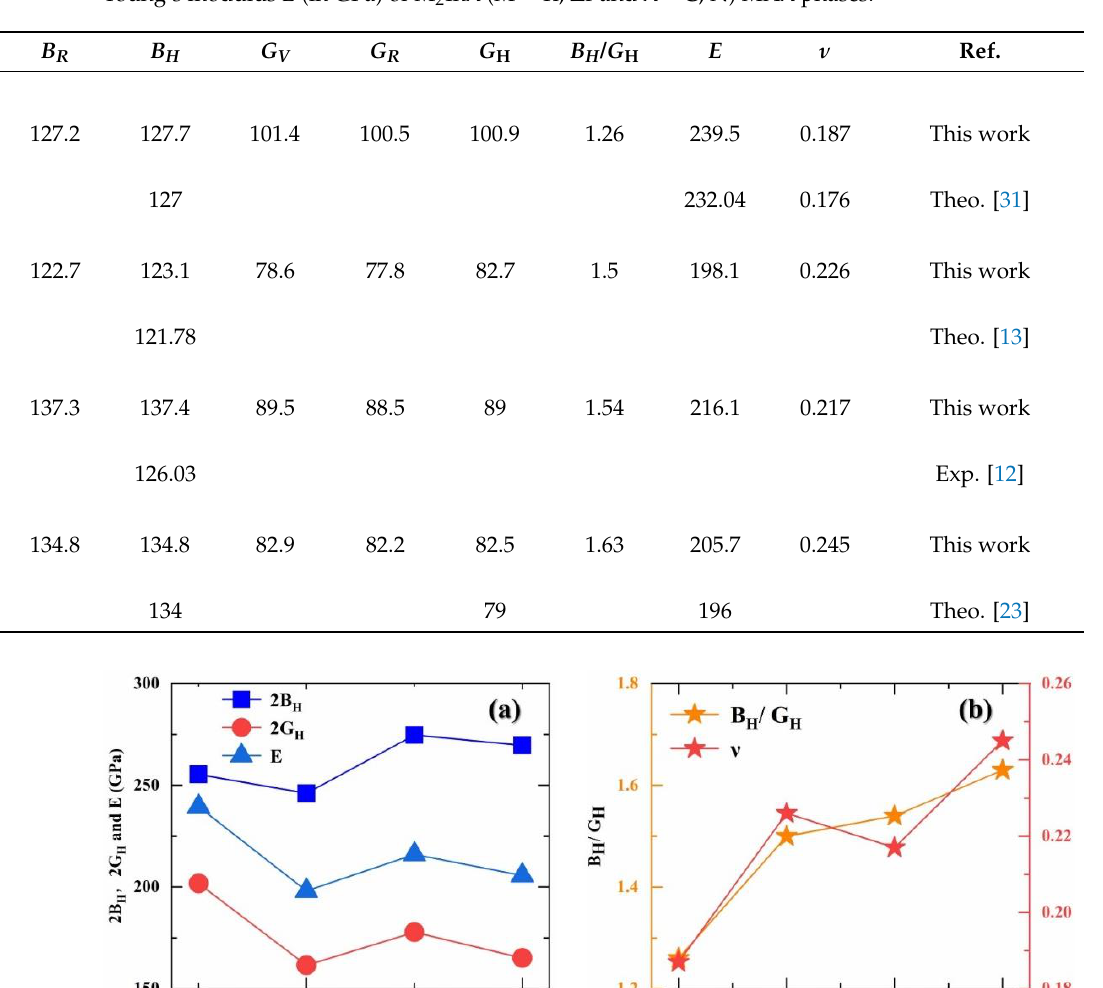
Figure 4. ( a ) Correlations between bulk modulus B (shear modulus G ) and Young’s modulus ( E ) of M 2 InX (M = Ti, Zr and X = C, N) MAX phases; ( b ) Variations of G H / B H and ν of M 2 InX (M = Ti, Zr and X = C, N) MAX phases. In graph ( a ), the values of bulk modulus and shear modulus are multiplied by the factor of 2 for a better comparison with Young ’ s modulus.